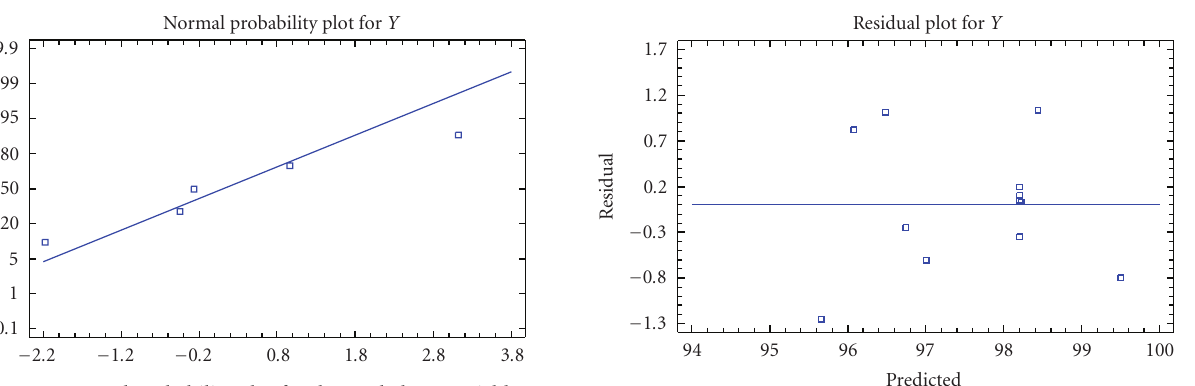
Figure 3: Residual plot of methyl esters yield for the second-order model.